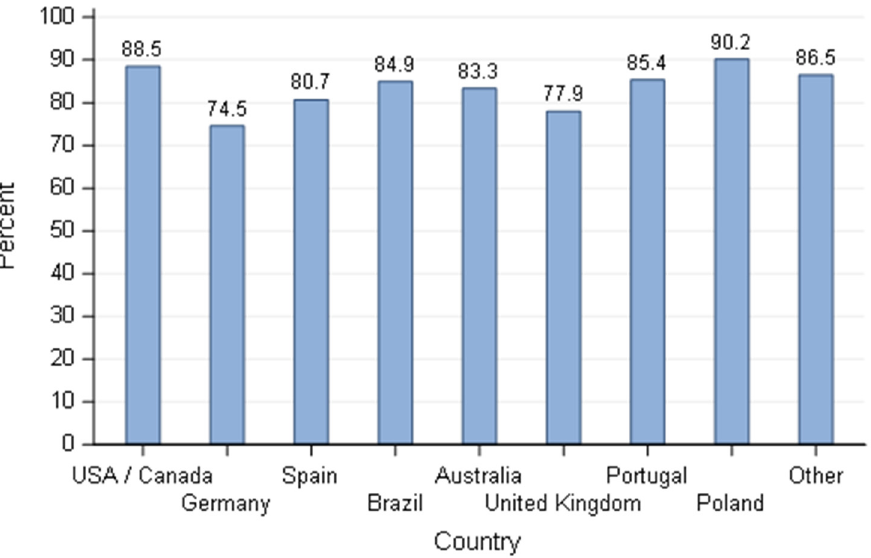
Figure 14. Percentage of dog breeders in the survey that spend more time with the bitch as an intervention to reduce stress before/during whelping by country—responders stating to intervene ( n = 618).